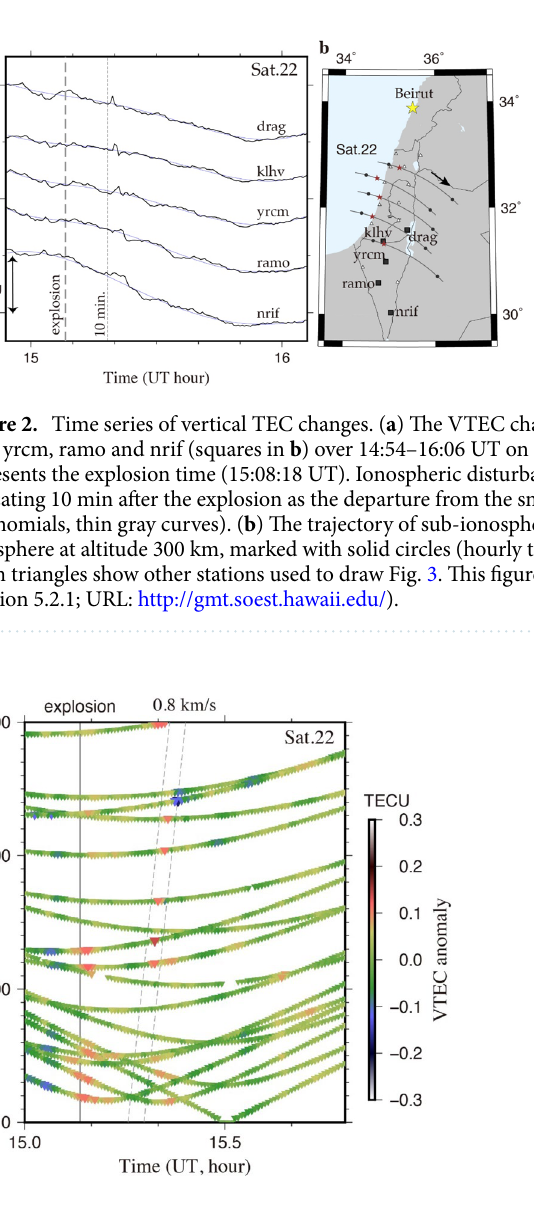
Figure 3. VTEC anomalies in the travel time diagram. The VTEC anomalies measured with the GPS satellite 22 are shown with colors as the function with time (horizontal axis) and distance from Beirut (vertical axis), calculated along the surface assuming the Beirut explosion point at (33.901 N, 35.519 E). The TEC disturbances by the explosion are clear for the distances exceeding ~ 120 km and propagate with the apparent velocity of 0.8 km/s (dashed lines), the sound wave speed at altitude ~ 200 km. Generic Mapping Tools (version 5.2.1; URL: http://gmt.soest .hawai i.edu/) has been used to generated this